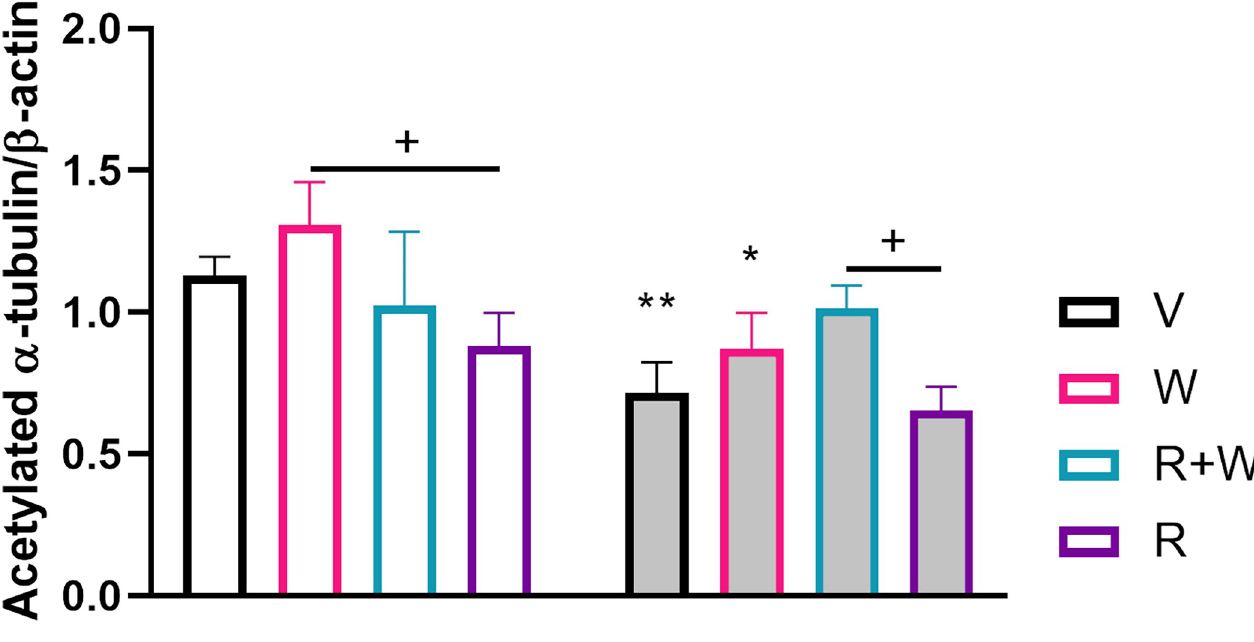
Fig 2. Effect of drug treatments on tubulin acetylation at K40 in the prefrontal cortex of stressed and non-stressed animals. We found higher expression of acetylated tubulin in controls treated with V+V when compared to their stressed counterparts. The use of V+W in controls increased the expression of acetylated tubulin in contrast to the control group treated with R+V and also did so when both drugs were administered simultaneously under stress conditions in comparison with those subjected to stress and treated with R+V. An � indicates significant differences between controls exposed to cannabinoid drugs and their respective V+V control group. Intragroup comparisons between drug-treated mice are indicated by an underlined +. Otherwise underlined � pointed out significant comparisons between stressed mice and their matched counterparts. CTR, control; STS, stress; V, vehicle; W, WIN55212.2; R, rimonabant. One, two or three symbols indicate P < 0.05; P < 0.01, P < 0.001, respectively.